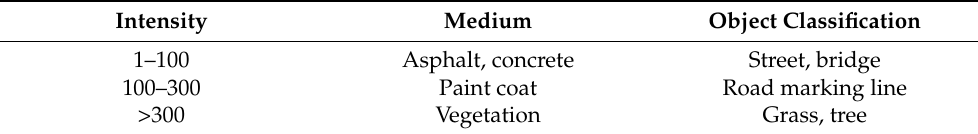
Table 1. Values of laser reflectivity of different